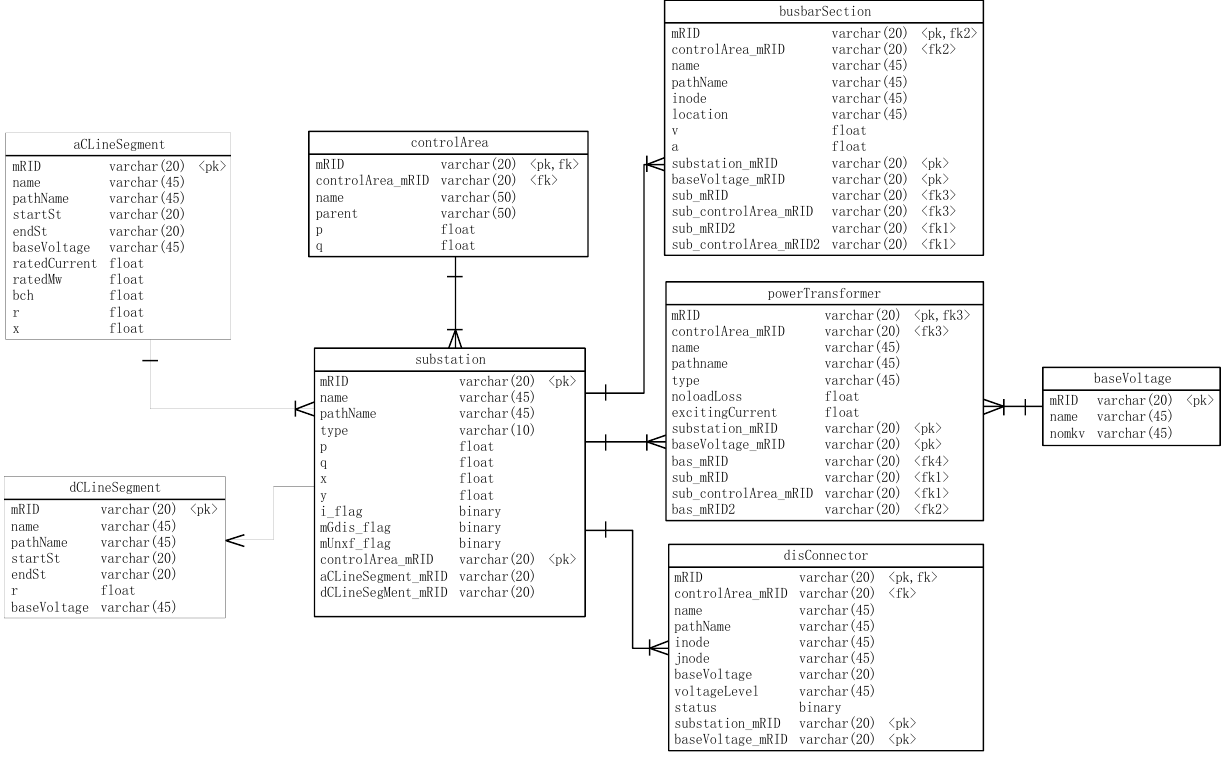
Fig. 7 Schema of model data in relational database.